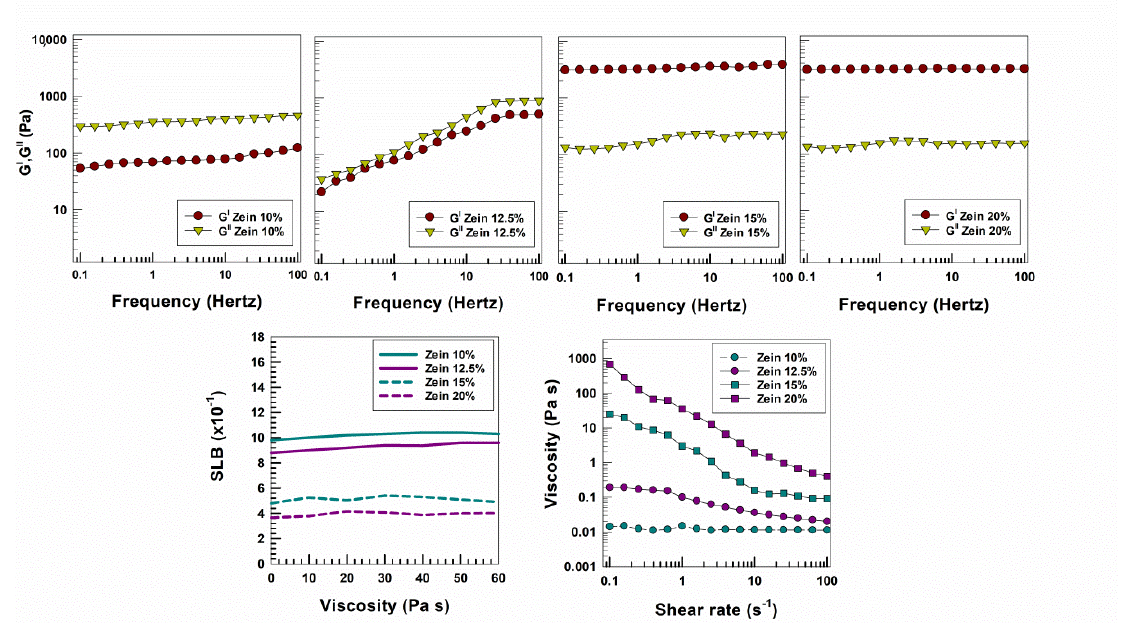
Figure 1. Evaluation of elastic (G') and viscous (G'') moduli, solid liquid balance (SLB) and viscosity of zein formulations (made up of 10%, 12.5%, 15%, 20% w/v of protein) as a function of frequency, time and shear rate, respectively.